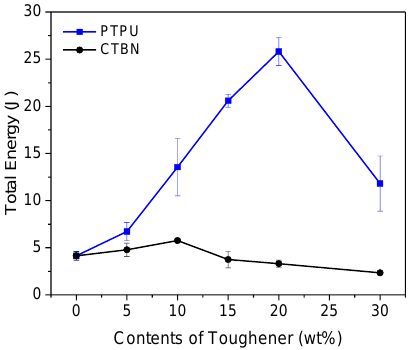
Figure 8. Total absorbed energy of the PTPU- and CTBN-toughened epoxy adhesives as a function of toughening agent contents.